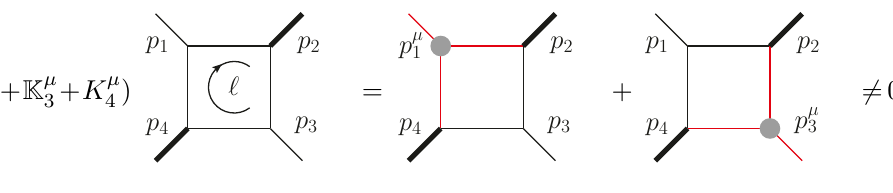
Figure 4 . Anomalous conformal Ward identity for the two-mass-easy 6D box